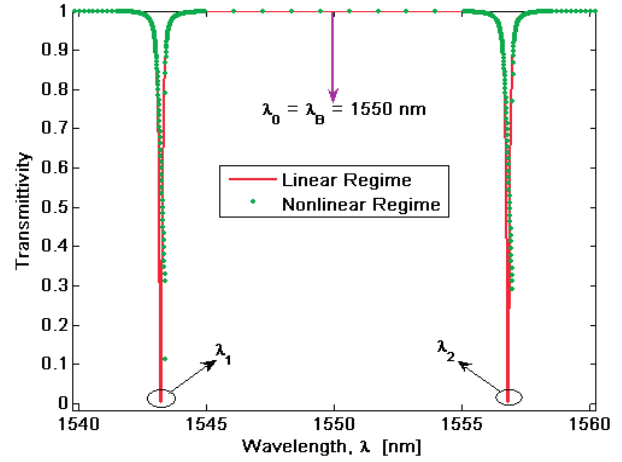
Figure 4. BMR spectral response in linear and nonlinear